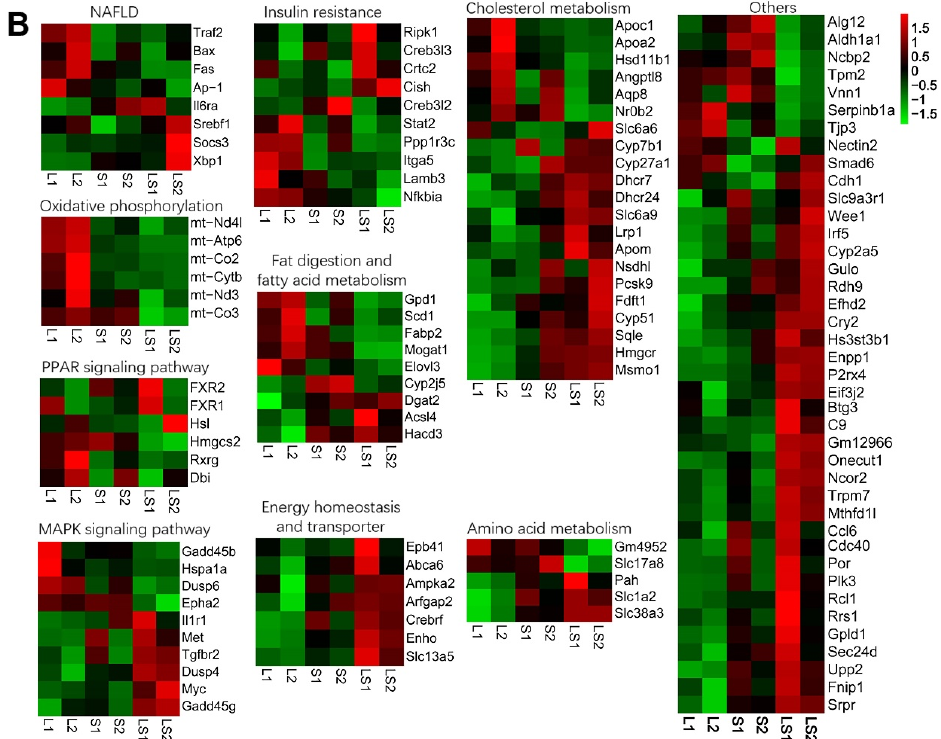
Figure 7. ( A ) Enrichment analysis of differentially expressed genes by KEGG pathway. ( B ) Heatmap of differentially expressed genes.